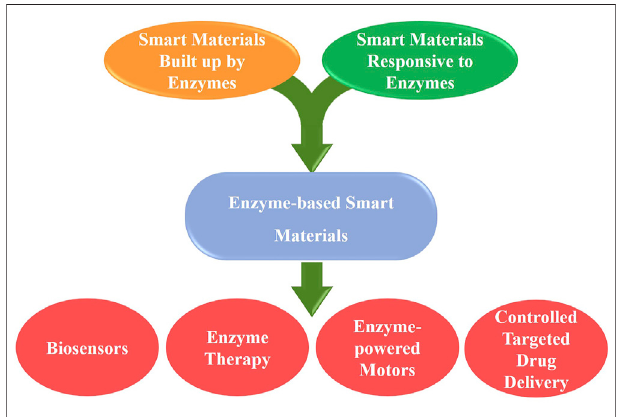
FIGURE 1 | Focuses of this editorial on enzyme-based smart